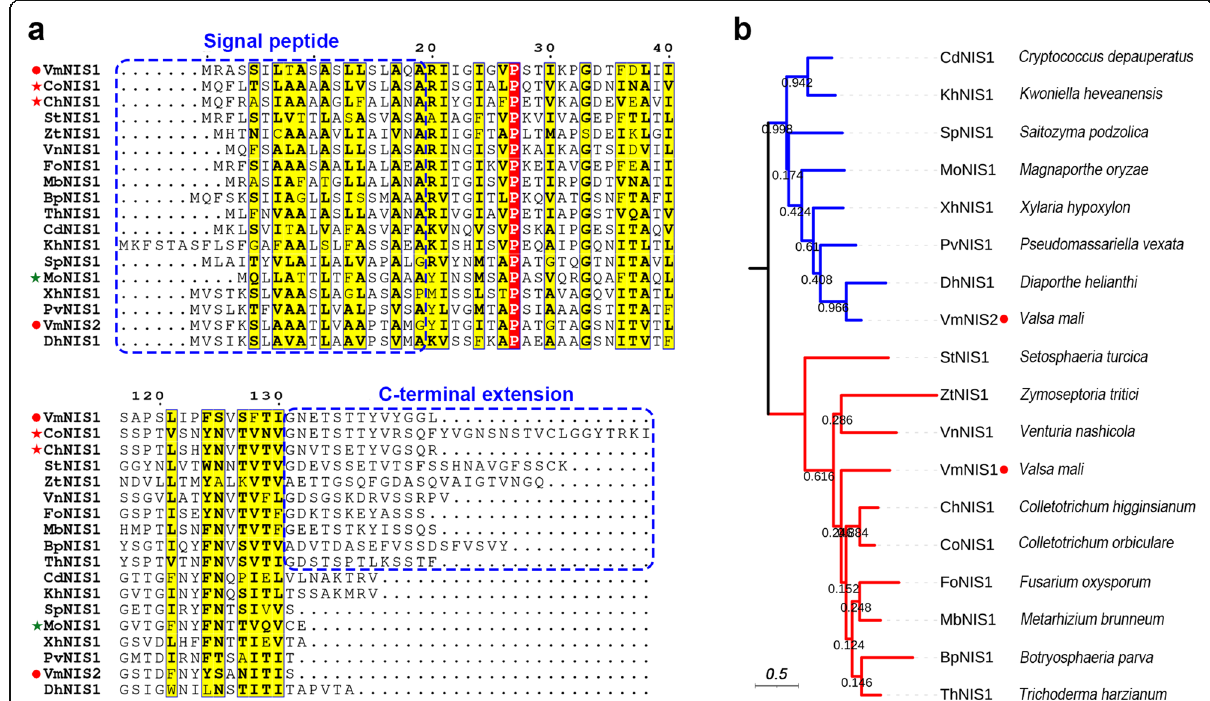
Fig. 1 VmNIS1 and VmNIS2 are distantly related. a Multiple sequence alignment of VmNIS1, VmNIS2 and their homologous sequences by ClustalW. VmNIS1 and VmNIS2 from Valsa mali , CoNIS1 from Colletotrichum orbiculare , ChNIS1 from C. higginsianum , MoNIS1 from Magnaporthe oryzae , StNIS1 from Setosphaeria turcica , ZtNIS1 from Zymoseptoria tritici , VnNIS1 from Venturia nashicola , FoNIS1 from Fusarium oxysporum , MbNIS1 from Metarhizium brunneum , BpNIS1 from Botryosphaeria parva , ThNIS1 from Trichoderma harzianum , CdNIS1 from Cryptococcus depauperatus , KhNIS1 from Kwoniella heveanensis , SpNIS1 from Saitozyma podzolica , XhNIS1 from Xylaria hypoxylon , PvNIS1 from Pseudomassariella vexata and DhNIS1 from Diaporthe helianthin were selected for analysis. VmNIS1 and VmNIS2 are indicated by red circles. The blue dashed squares separately represent the predicted signal peptides and the extended region among selected sequences. Partial results of the alignment were shown. b Maximum-likelihood phylogenetic analysis of selected NIS1-like proteins showing that VmNIS1 and VmNIS2 are clustered into two distinct clades. Bootstrap support value for each branch is indicated. VmNIS1 and VmNIS2 are indicated by red circles. Red and green stars respectively indicate the proteins with and without cell death-inducing